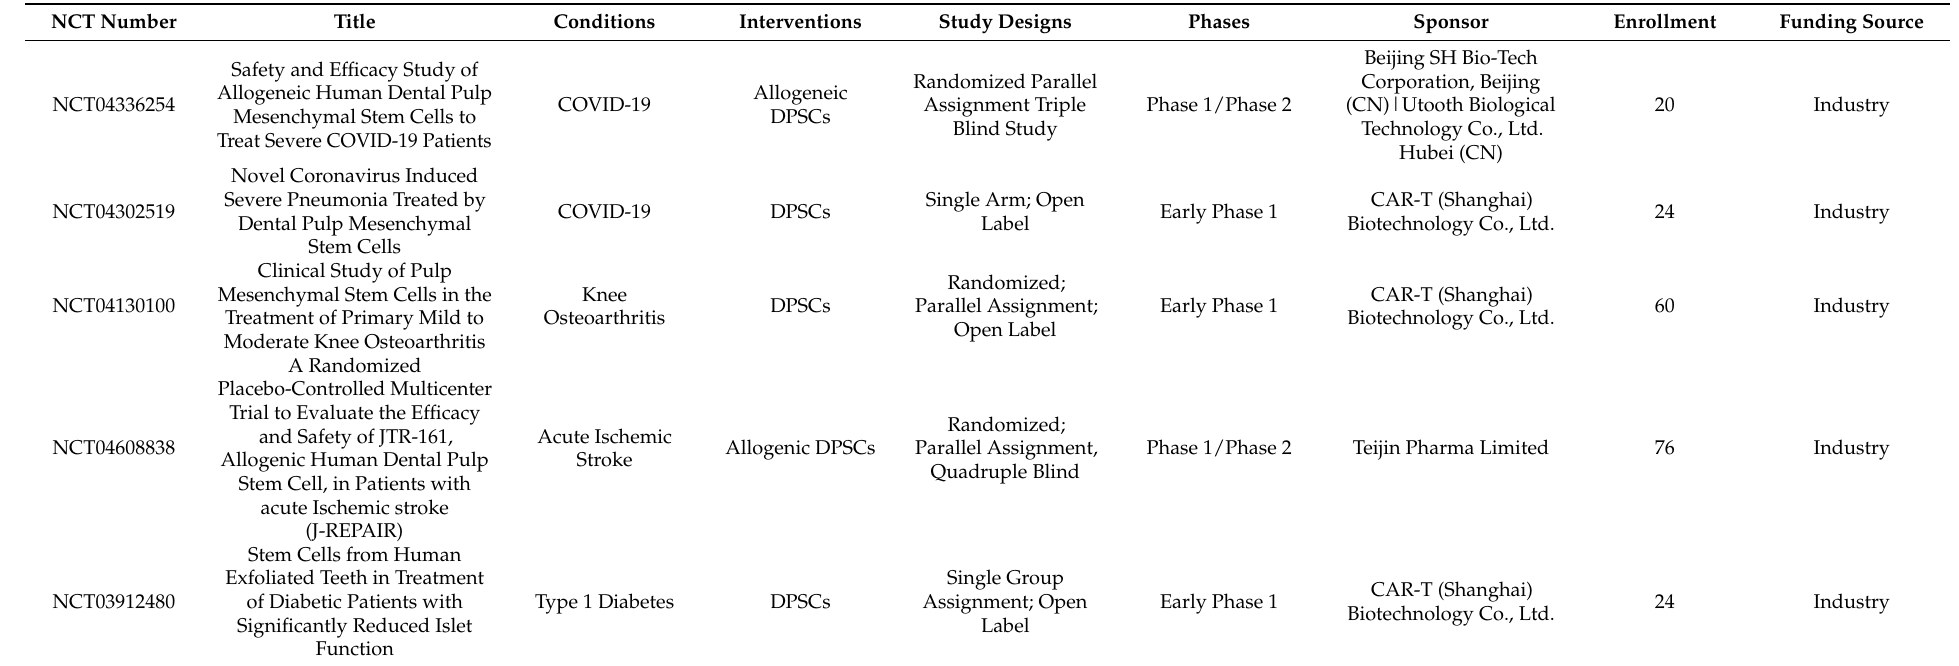
Table 3. Clinical trials using dental stem cells as